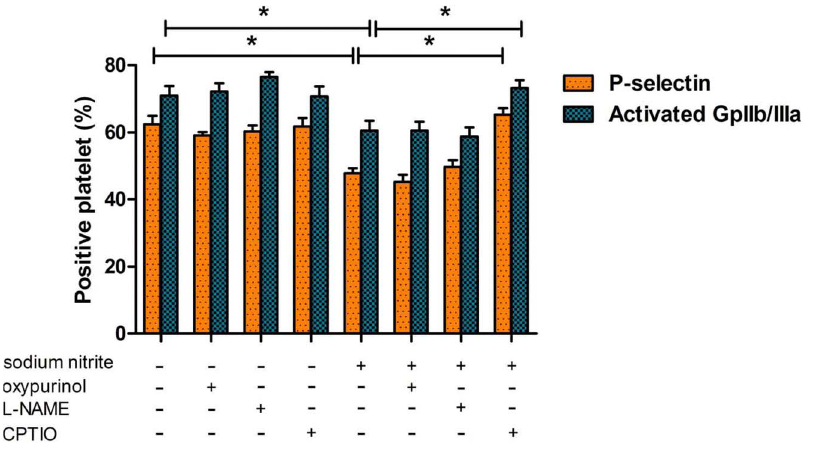
Figure 5. Platelet inhibition by nitrite is mediated by its reduction to NO. NO scavenger (CPTIO) or enzyme inhibitors (L-NAME for NOS and oxypurinol for XOR) were preincubated at 37 u C for 5 minutes with platelet-rich plasma + erythrocytes before nitrite addition and then thrombin- induced P-selectin exposure and gpIIb/IIIa activation were analyzed (mean Hct 43.4%, pO 2 55.4 mmHg, thrombin 1 U/mL, nitrite 1 m M, oxypurinol 100 m M, L-NAME 300 m M, CPTIO 200 m M, n=6, * p , 0.05).